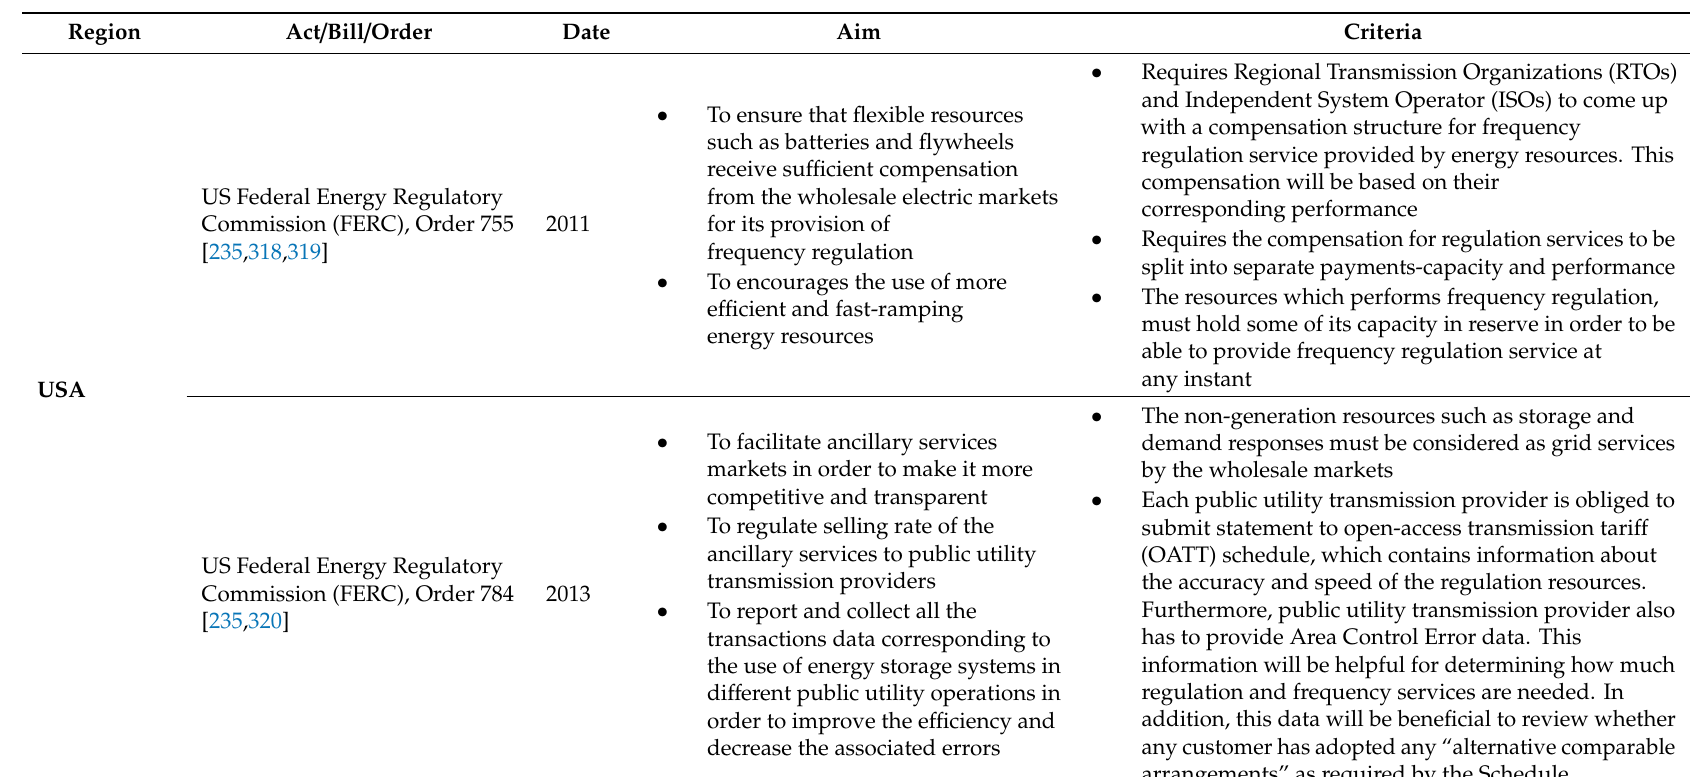
Table 22. Globally existing policies and standards regarding